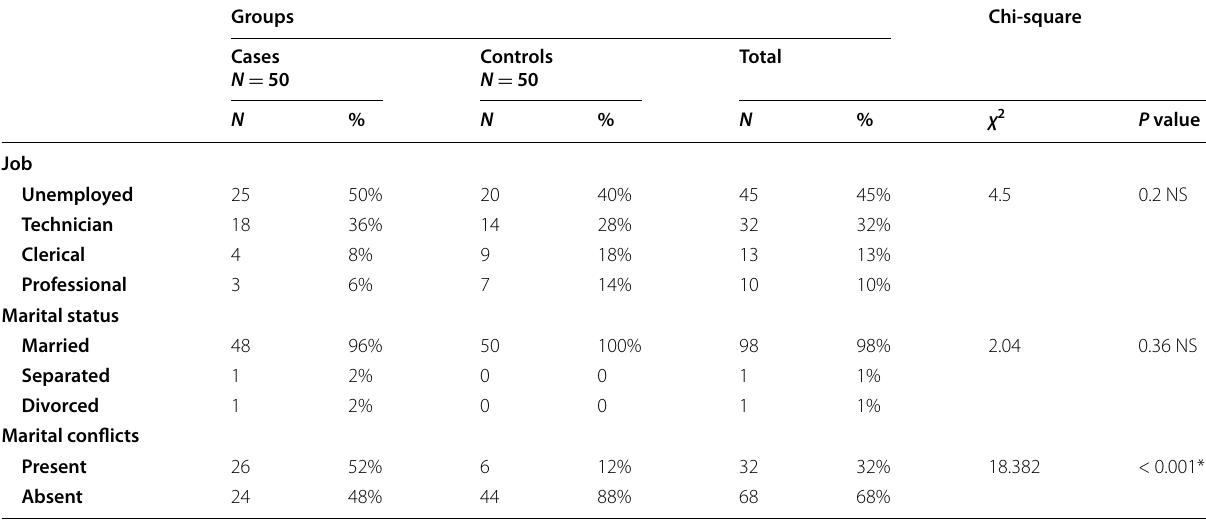
Chi-square test was used *Statistically significant ( P <